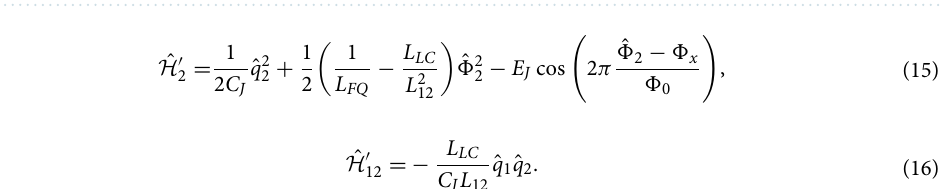
g , e and ( a ) j g , e , ( b ) j g , e , f , h , k , l , = = = g , e and ( c ) j g , e , ( d ) j g , e , f , h , k , l . Note that the = = =